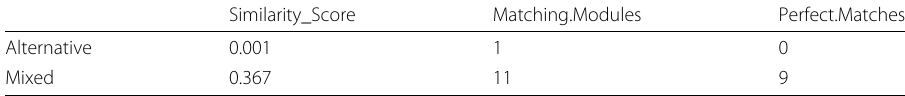
Table 7 Comparison of modular structures detected using the Infomap algorithm between the Main network and the Alternative or Mixed networks, based on module edge similarity